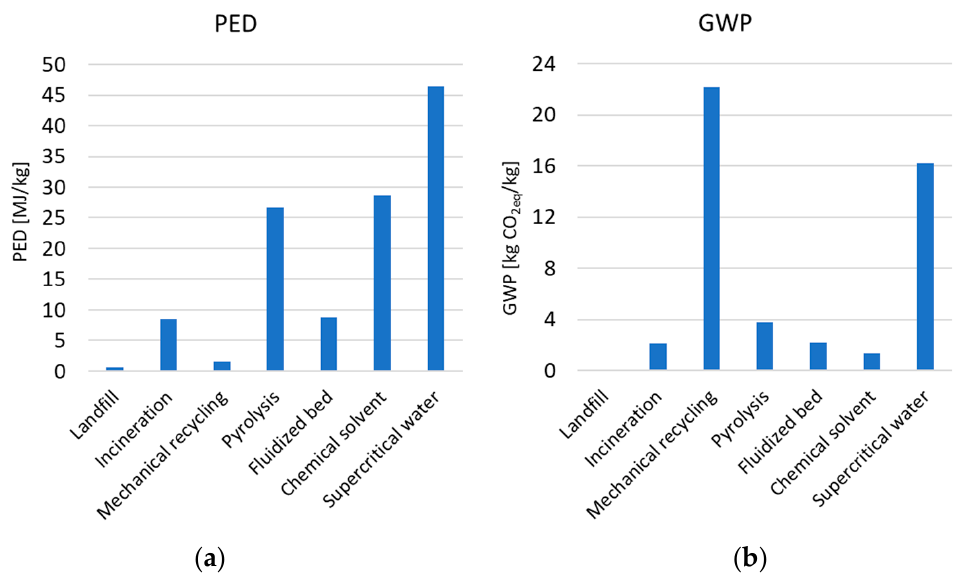
Figure 2. Averaged ( a ) PED and ( b ) GWP of the main EoL methods for composites, according to data from [16,26–33].